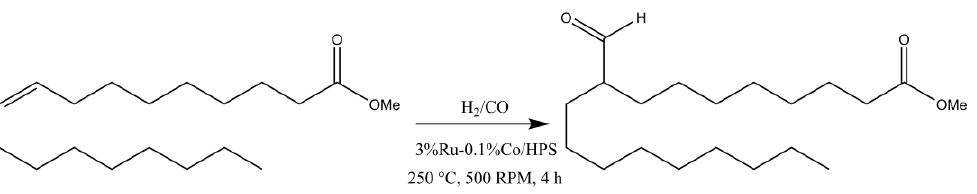
Figure 9. H NMR spectrum for hydroformylated product following the first methodology.